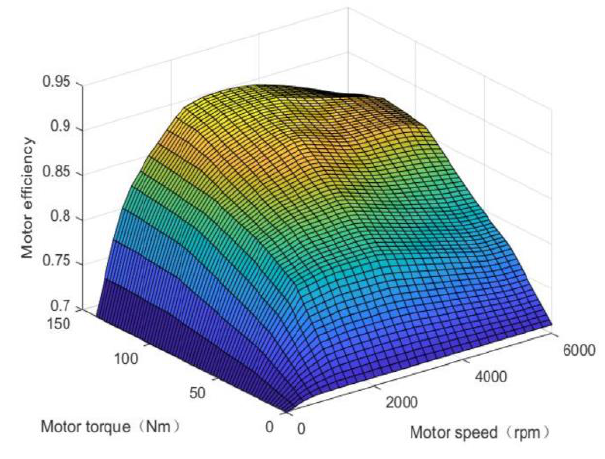
Figure 3. Motor efficiency.